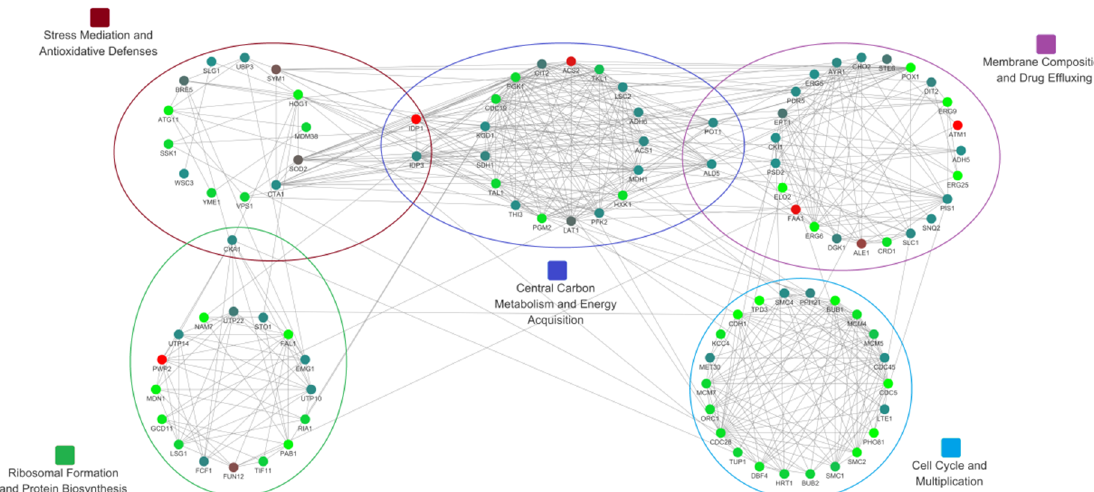
Figure 11. Protein–protein interaction network of T. roseum under cuminal exposure compared with the control. The proteins encoded by DEGs functioning in the fungal metabolism discussed in the context were selected. Interactions are shown by the lines connecting each node based on available evidence in the database. Interactions are integrated into different metabolic blocks indicated by the colored circles.